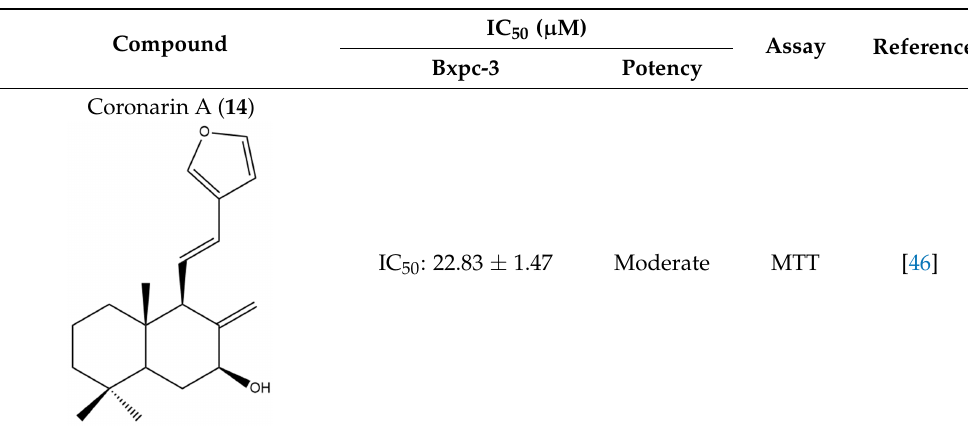
Table 17. Cytotoxic activities of labdane-type diterpenes from the Zingiberaceae against selected pancreatic cancer cell lines.